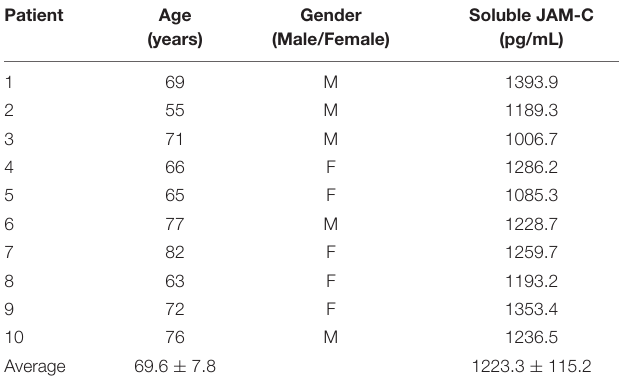
TABLE 1 | Clinical information of all patients and soluble JAM-C